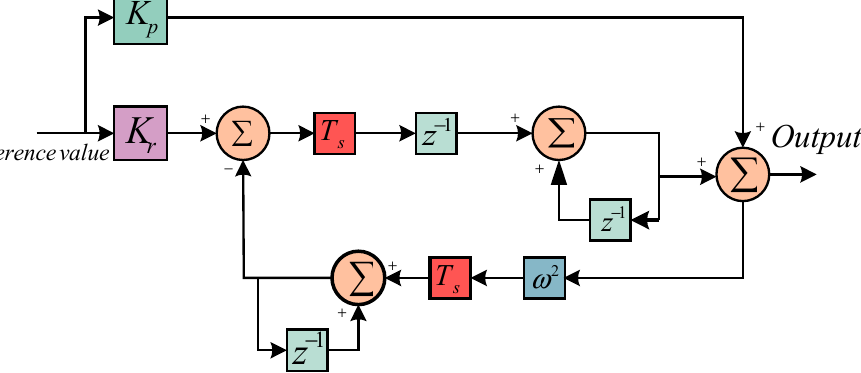
Figure 23. Structure of a discrete PR Controller.